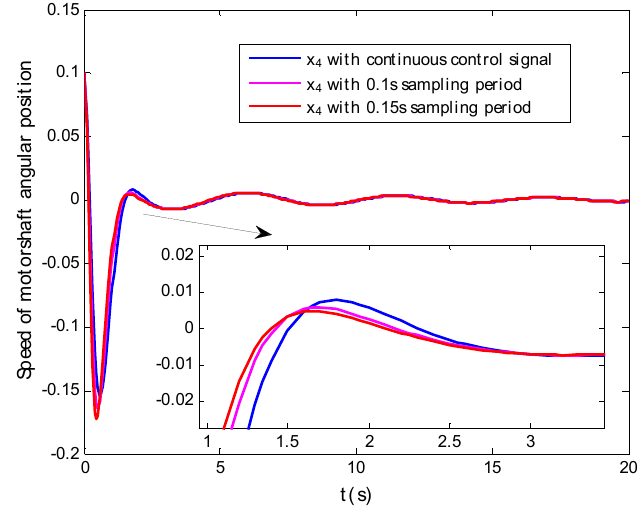
Figure 5. The trajectories of state x 4 with different sampling periods.